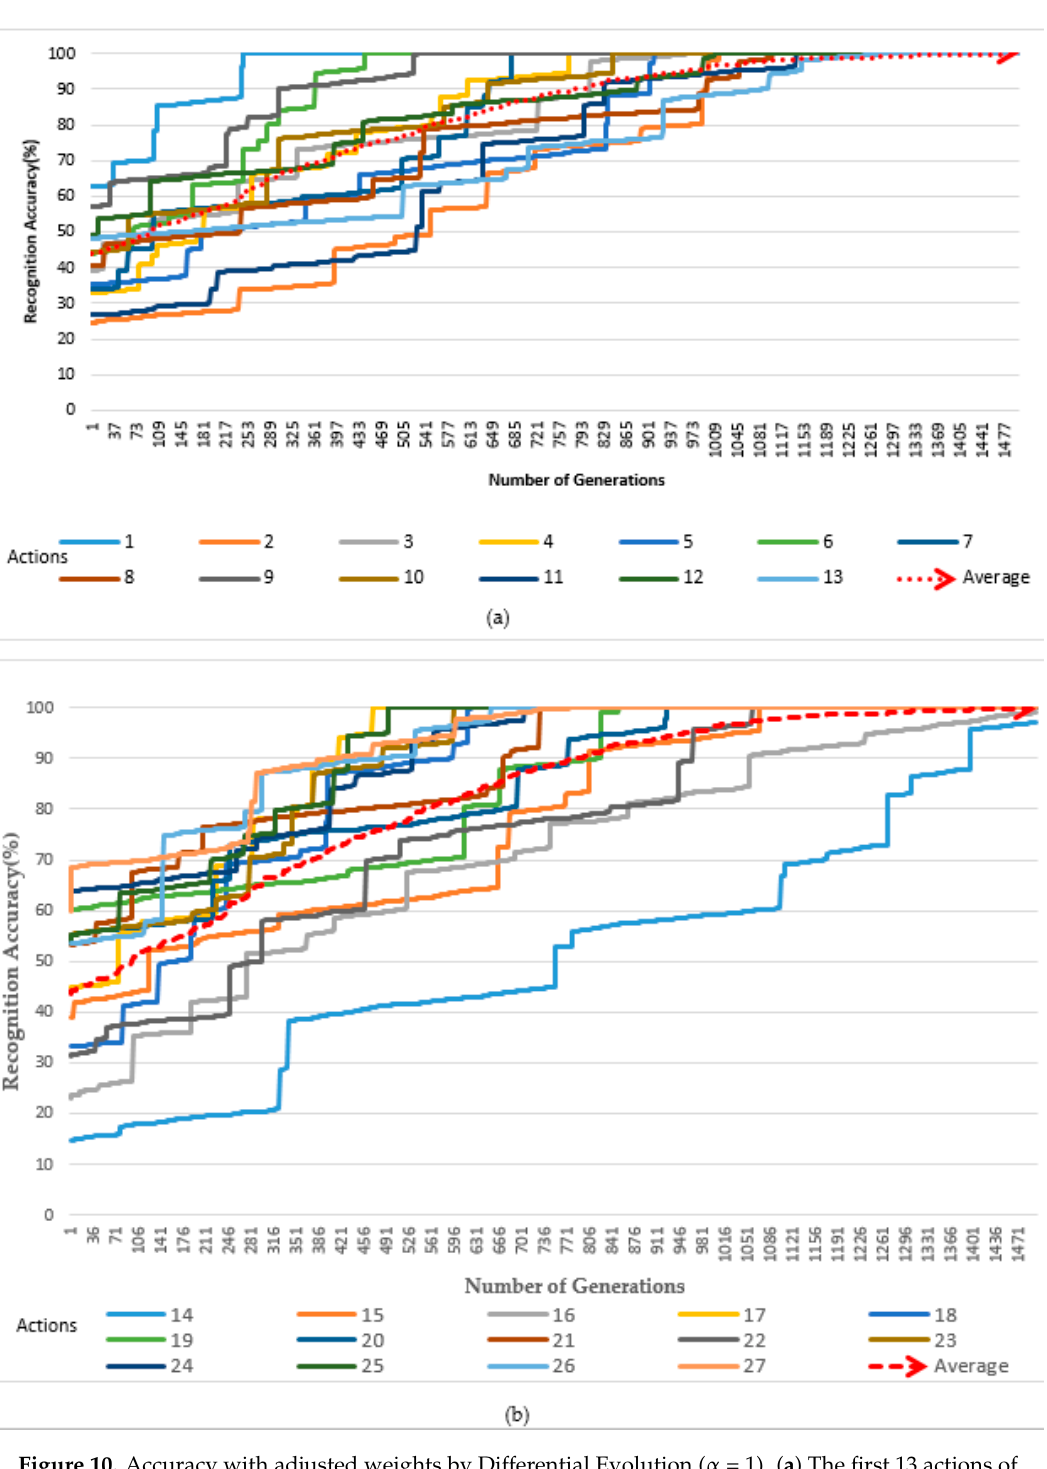
Figure 10. Accuracy with adjusted weights by Differential Evolution ( α = 1). (a) The first 13 actions of the datasets (1 to 13), (b) the last 14 actions of the datasets (14 to 27).